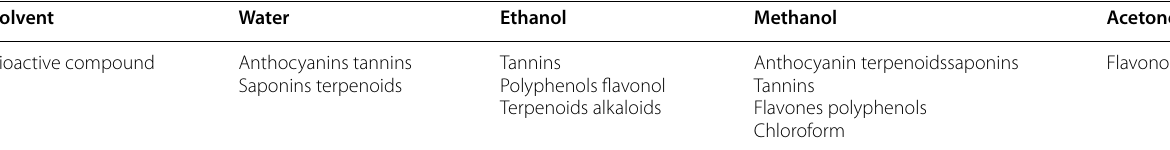
Table 3 Example of some extracted bioactive compounds by different solvents. Adapted from Azmir et al. (2013)